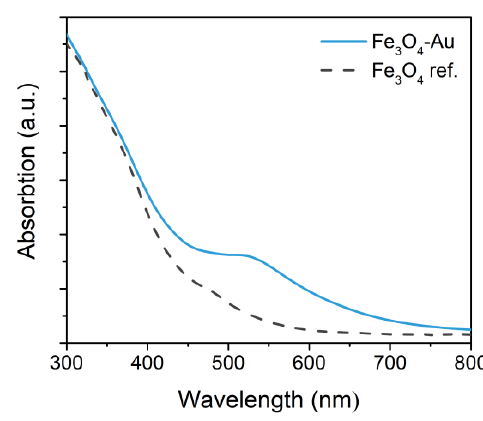
Figure 4. Extinction spectrum of Fe 3 O 4 -Au NPs measured on a toluene suspension and reference spectrum for the bare Fe 3 O 4 NPs from [57].